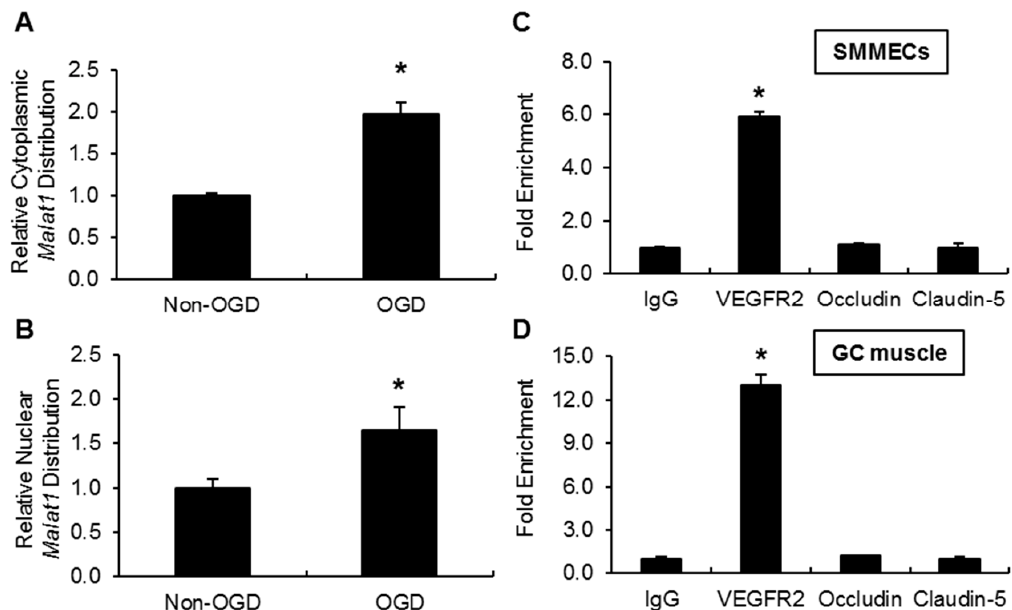
Figure 7. Malat1 physically associates with VEGFR2 in mouse-cultured SMMECs and mouse gastrocnemius muscles. ( A , B ) The subcellular localization of Malat1 was detected in mouse SMMEC cells. Nuclear, cytoplasmic, and total RNA were isolated from SMMEC cells with or without 16 h OGD treatment using the RNA Subcellular Isolation Kit (Active Motif, Carlsbad, CA, USA). Isolated RNAs were subjected to reverse transcription and qPCR analysis, with Malat1 from total RNA as endogenous control. ( C , D ) Interaction between Malat1 and VEGFR2 was revealed by RNA Immunoprecipitation. Total extracts of ( C ) cultured SMMECs and ( D ) mouse gastrocnemius muscles were immunoprecipitated with control IgG or anti-VEGFR2 antibody, and the complexes were analyzed for the presence of Malat1 by qPCR. Relative gene expression levels were calculated using the formula 2 −Δ C t with Δ C t = C t(target) – C t(control) ( n = 3). Data are expressed as mean ± SEM of two independent experiments with triplicate wells. * p < 0.05 vs. IgG group.